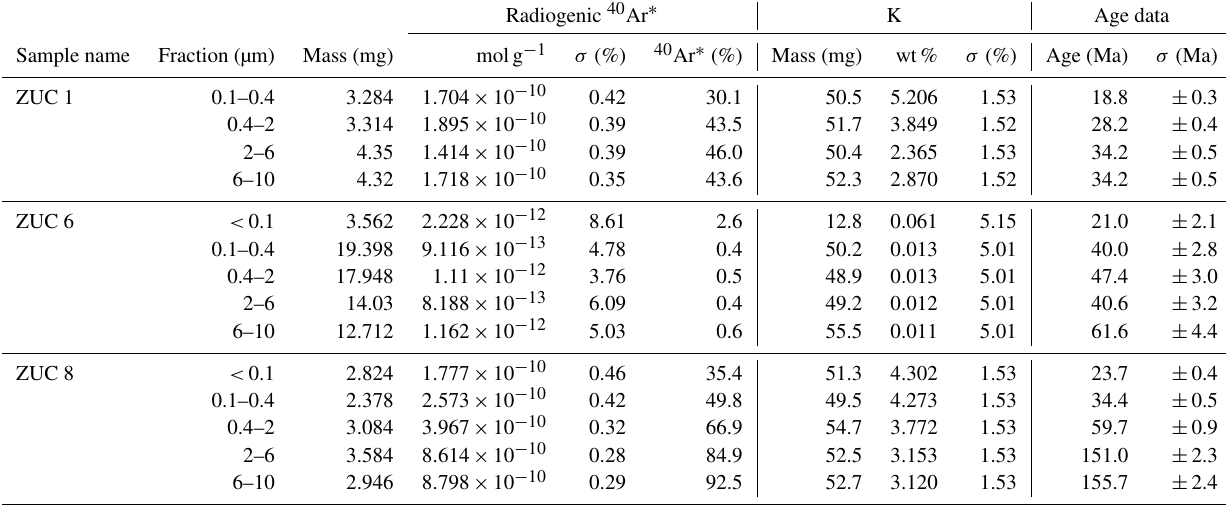
Table 3. K–Ar data of the three analysed